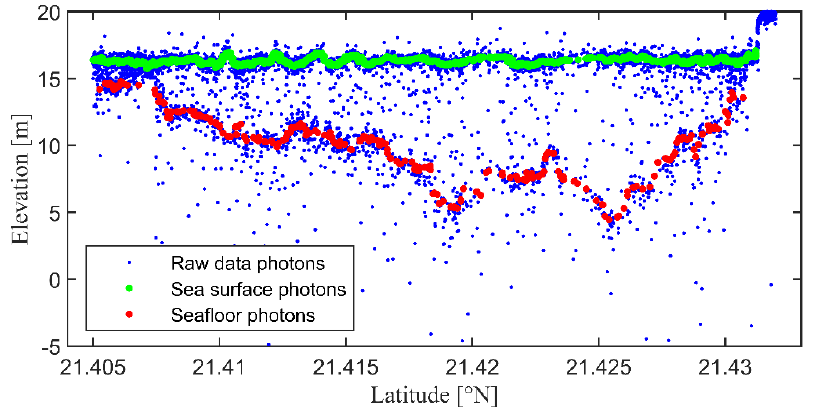
Figure 7. The raw photon point cloud of ATL03 for 20190908GT1R in the Oahu area.